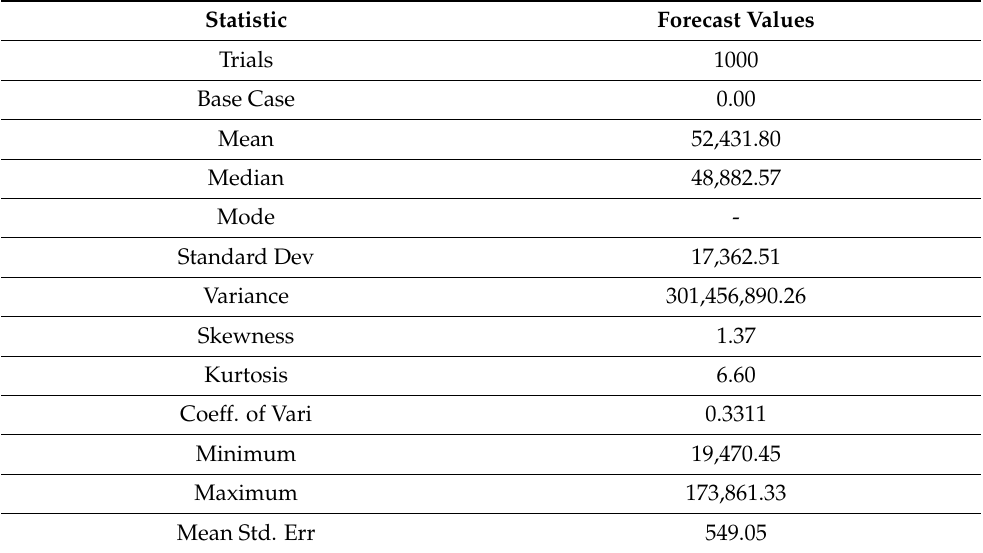
Table 12. Descriptive statistics of the probability distribution of the present value of incomes from the accommodation rental facilities for 10 years in the region of Poprad–Vysok é